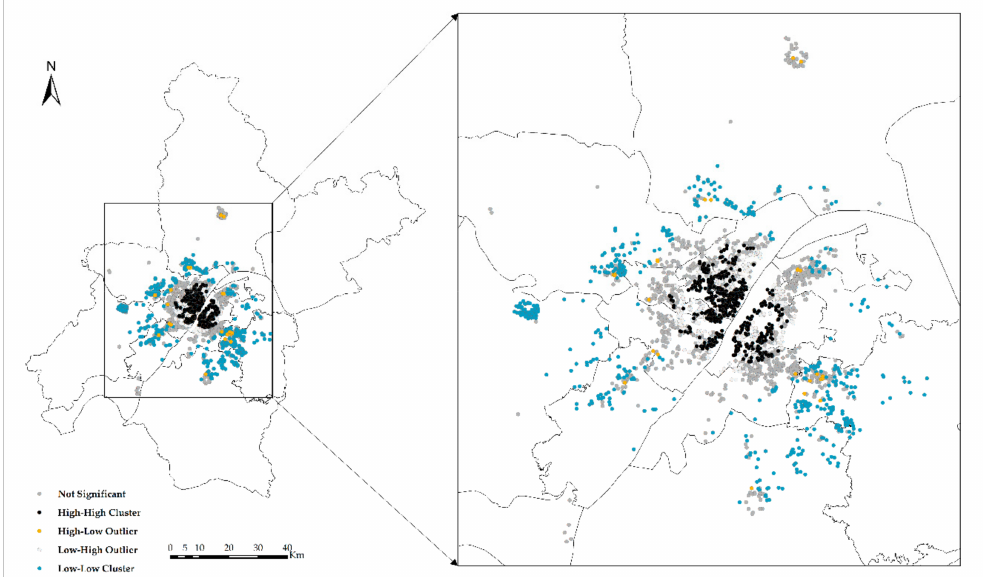
Figure 8. Clustering and outlier analysis of the NTLI.